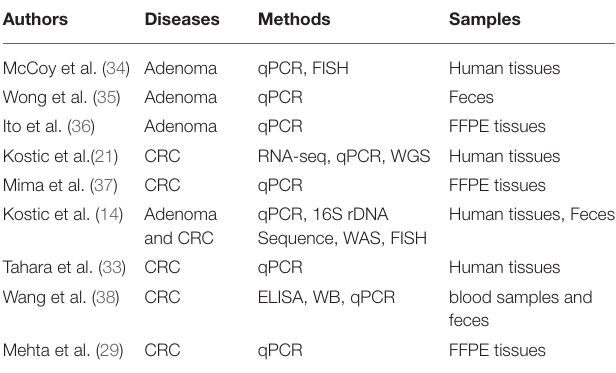
TABLE 1 | Studies with positive detection of Fusobacterium in colorectal